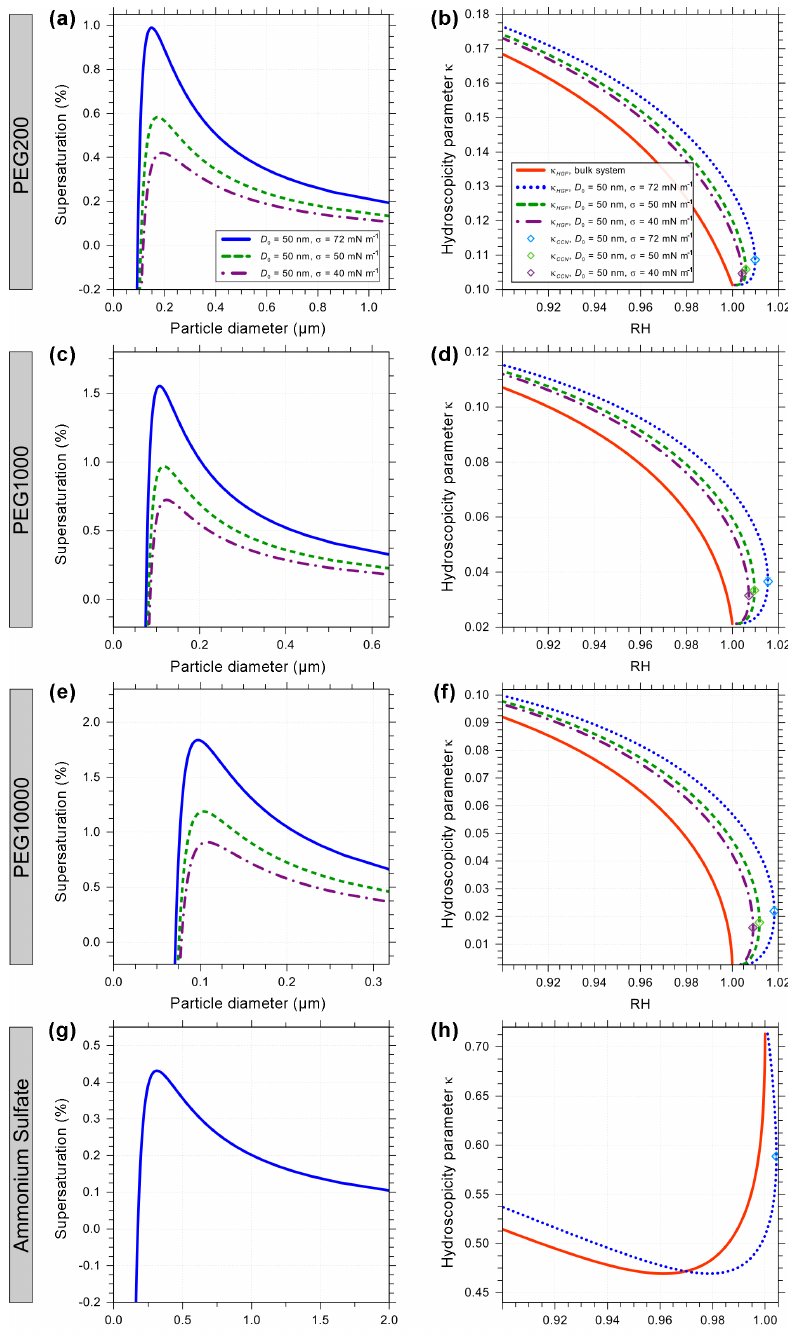
Figure 6. Left panels: Köhler curves (equilibrium water supersaturation vs. wet particle diameter) for the single solute PEG systems and ammonium sulfate. Right panels: predicted hygroscopicity parameter κ in the high-RH range from 90% RH to > 100% RH (i.e., up to supersaturated conditions with respect to liquid water). The curves are based on AIOMFAC-predicted HGF and κ -Köhler theory for particles of dry diameter D 0 = 50nm with different values for the air–particle surface tension σ , as indicated in (a, b) ; all for a temperature of 298.15K. The red curve shows the prediction for the bulk system for the water activity (equilibrium RH) range from 0.9 to 0.99999. The predicted hygroscopicity parameters at CCN activation, κ CCN , are shown by the open diamonds for the given particle properties ( D 0 , σ) , with error bars denoting the numerical resolution of the corresponding maxima in equilibrium supersaturation (related to the maxima of the Köhler curves). Note the differences in axis